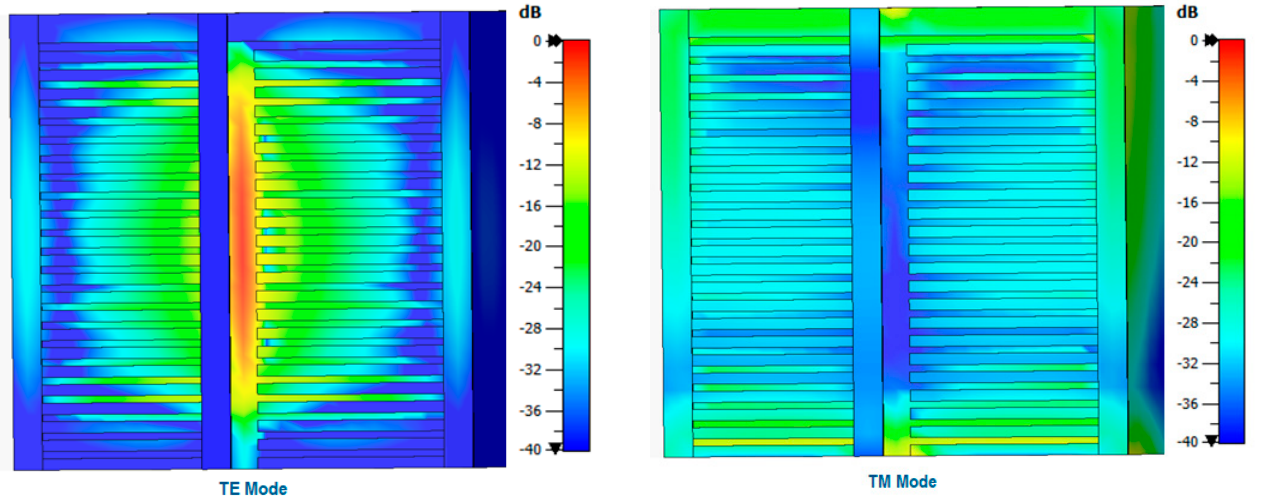
Figure 3. Electromagnetic field distribution for TE and TM modes in the peak of absorption.